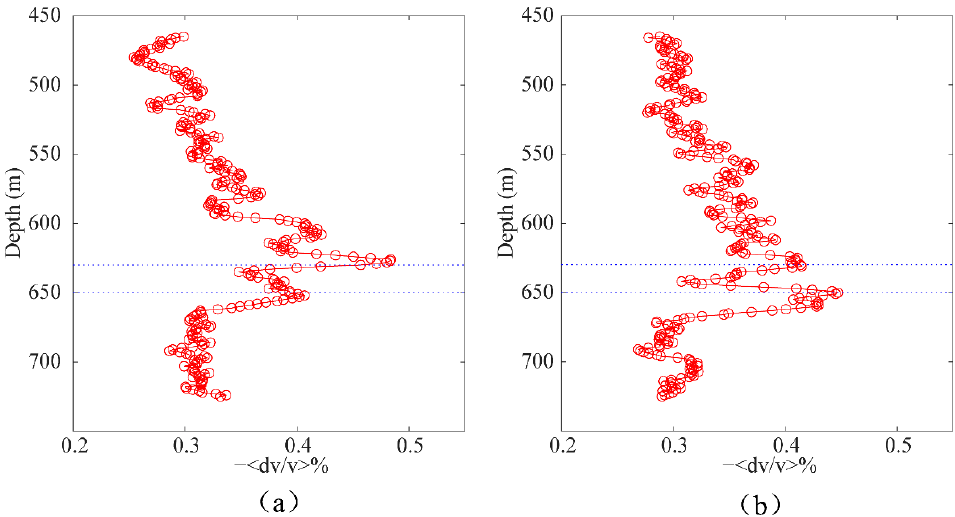
Figure 17. ( a , b ) Estimated mean velocity change curves from upgoing and downgoing waves, re-